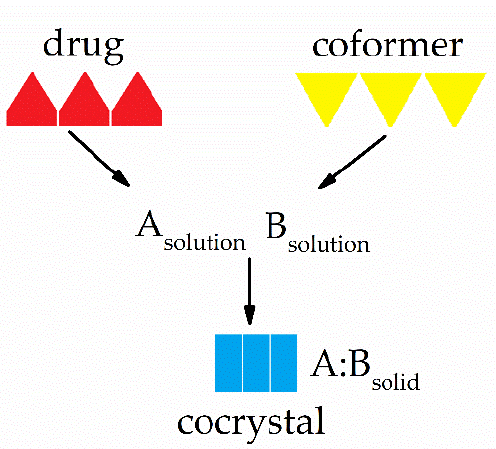
Figure 3. Formation of a cocrystal A:B from the generation of supersaturation by dissolving components A (drug) and B (coformer) in a microphase of solvent. Adapted from Rodriguez-Hornedo et al. (2006).